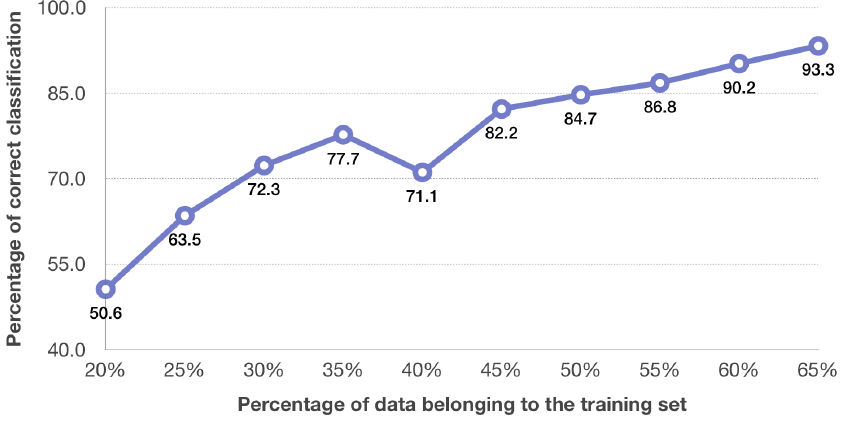
Figure 5. Efficiency of Fuzzy ST-GCN